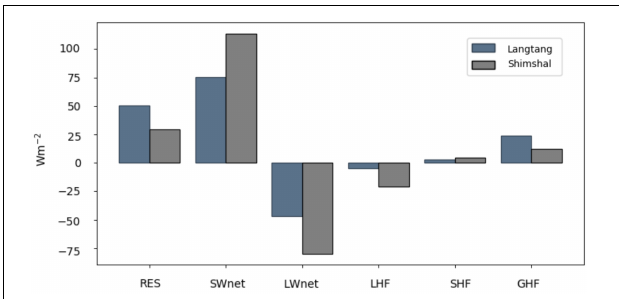
FIGURE 7 | The average residual flux (RES), shortwave net (SWnet), longwave net radiation (LWnet), latent heat flux (LHF), sensible heat flux (SHF), and ground heat flux (GHF) for all glacierized cells in Langtang (blue) and Shimshal (gray) for the three melt seasons (May–September).